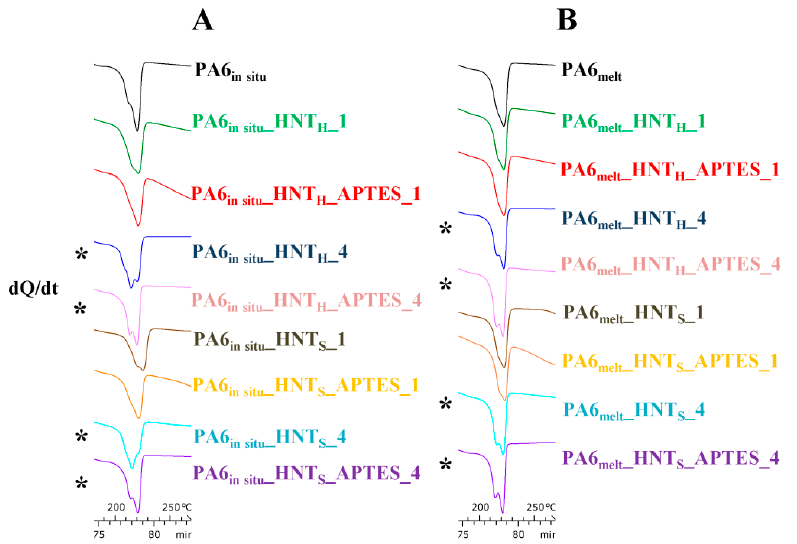
Figure 4. Heating scans of ( A ) PA6_HNT in situ and ( B ) PA6_HNT melt nanocomposites. Samples characterized by the presence of γ form are highlighted with a star (*).